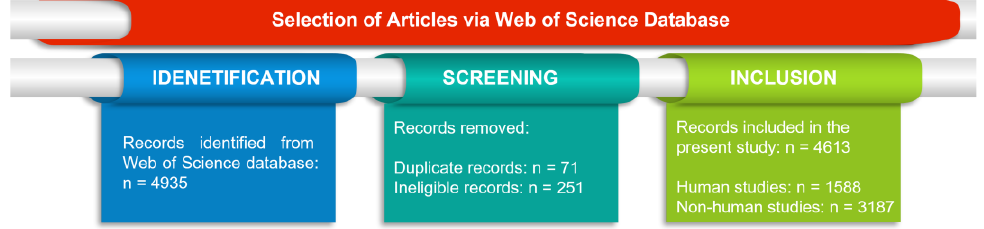
Figure 1. The studies extracted from Web of Science (date: 1 August 2022) containing the terms (palaeogenom* OR paleogenom* OR archaeogenom* OR “archaic DNA” OR archeogenom* OR “Ancient DNA” OR (archeology* NEAR/1 DNA) OR (archaealogy* NEAR/1 DNA) OR “extinct DNA” OR (historic* NEAR/1 DNA) OR (paleo* NEAR/1 DNA) OR (palaeo* NEAR/1 DNA). Further, the studies were manually examined to verify the authenticity of the derived data. The screening criteria include checking the relevance by title, abstract and keywords.